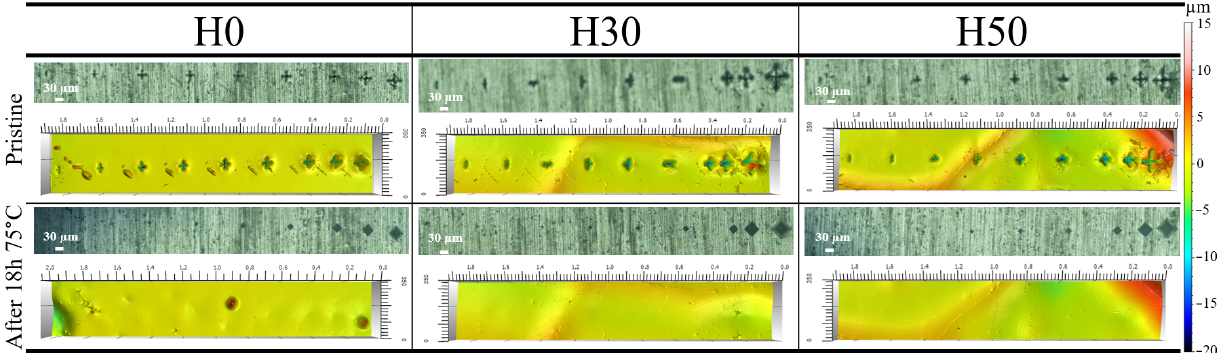
Figure 9. Optical and interferometric surface analysis results of indented coatings before and after 18 h at 75 °C.